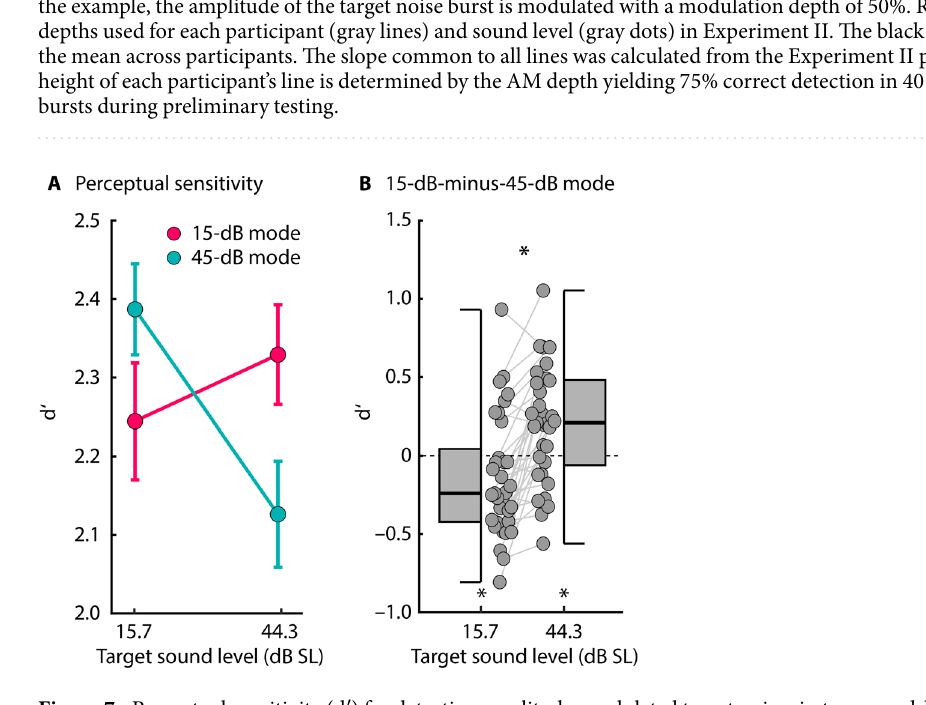
There was no effect of Context (F 1,32 = 0. 0.266, p = 0.610, η 2 p = 0.008) nor an effect of Target-Intensity Category (F 1,32 = 0. 587, p = 0. 449, η 2 p = 0.018). The latter was expected because we normalized the AM depth for individual target-sound levels based on the Experiment II pre-test (Fig. 6) to achieve equal task difficulty (i.e., AM-detection performance) for each target-sound level. for AM on higher-intensity targets compared to lower-intensity targets when ambient sound level was low, but that sensitivity was enhanced for AM on lower-intensity targets compared to higher-intensity targets when ambi- ent sound level was high. The statistical results of Experiment II resemble the dependency of neural data on statistical context for the slow negative potential demonstrated in Experiment I (Fig. 5), but does not mirror the context effects related to neural adaptation to sound-level statistics (Fig. 4) 10,11,17,18,21 .